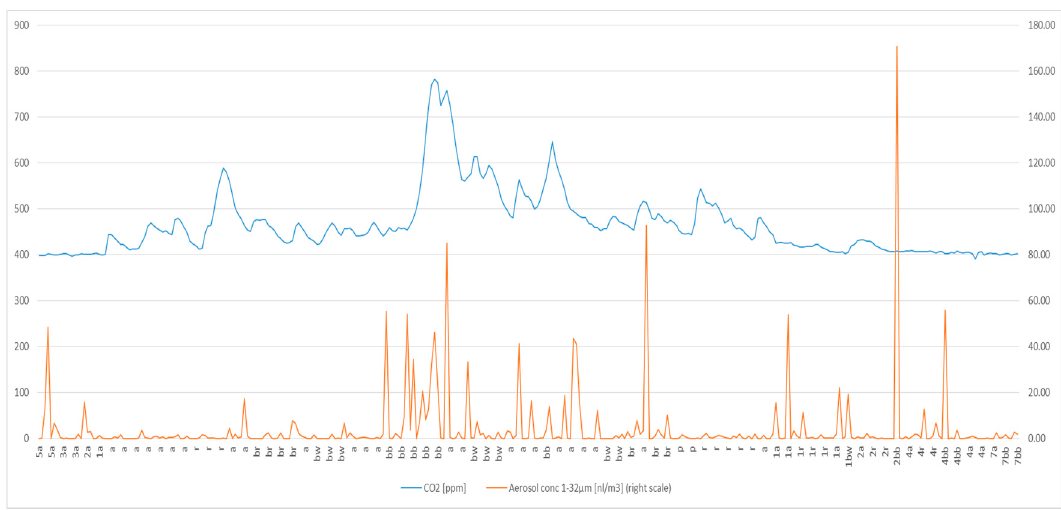
Figure 3. Distribution of aerosols and CO 2 over time indicating the current activity (see Table 2) as ordinate. Table 3. Concentration of liquid released over one hour, by activity.